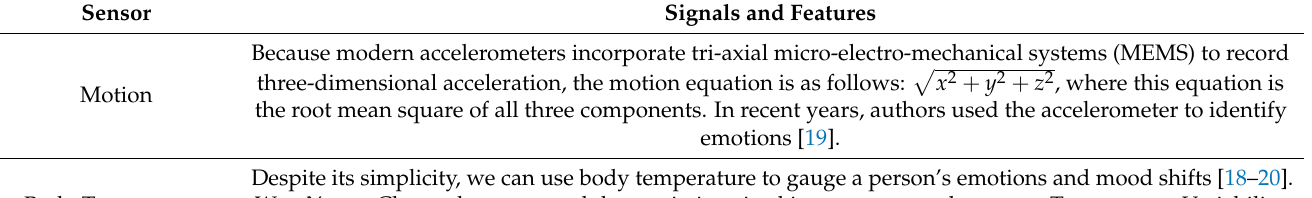
Table 1. List of some on-body sensors that have been used for emotion detection. Sensor Signals and